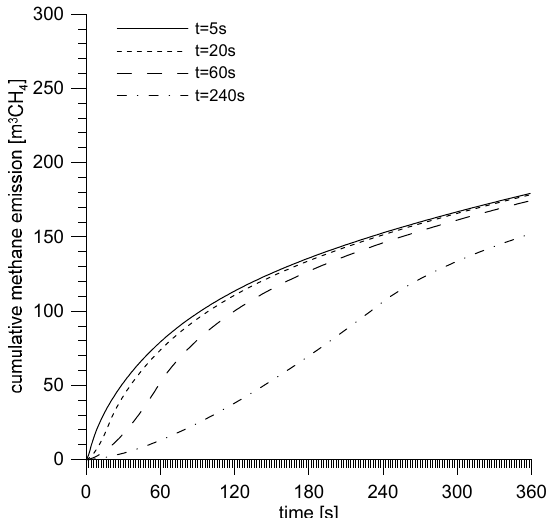
Figure 19. Model cumulative emissions of methane determined based on the plane sheet model during Zofiówka outburst.